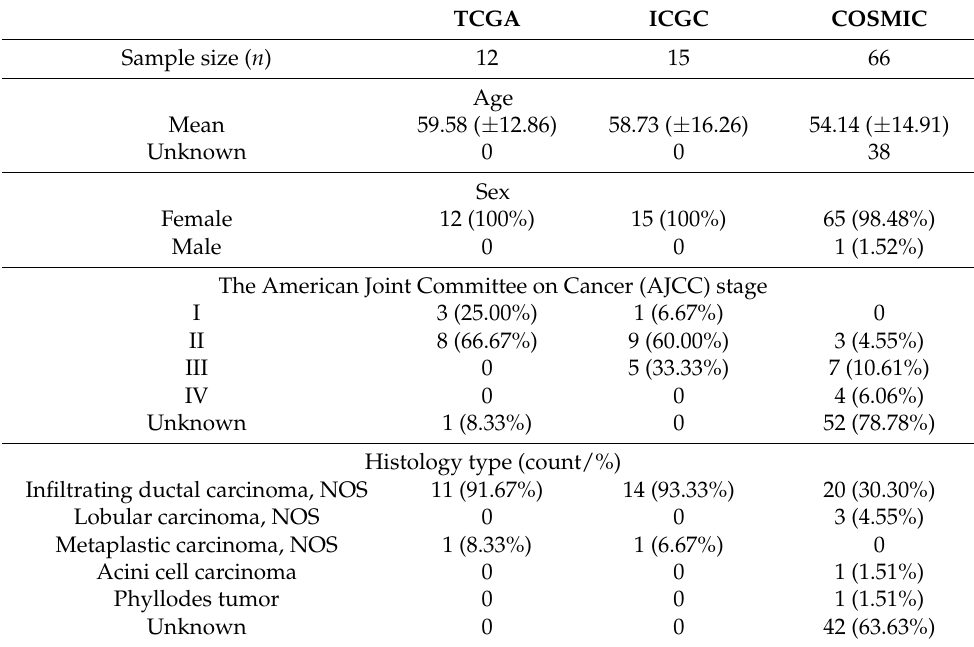
Table 1. Characteristics of BRCA1 -positive